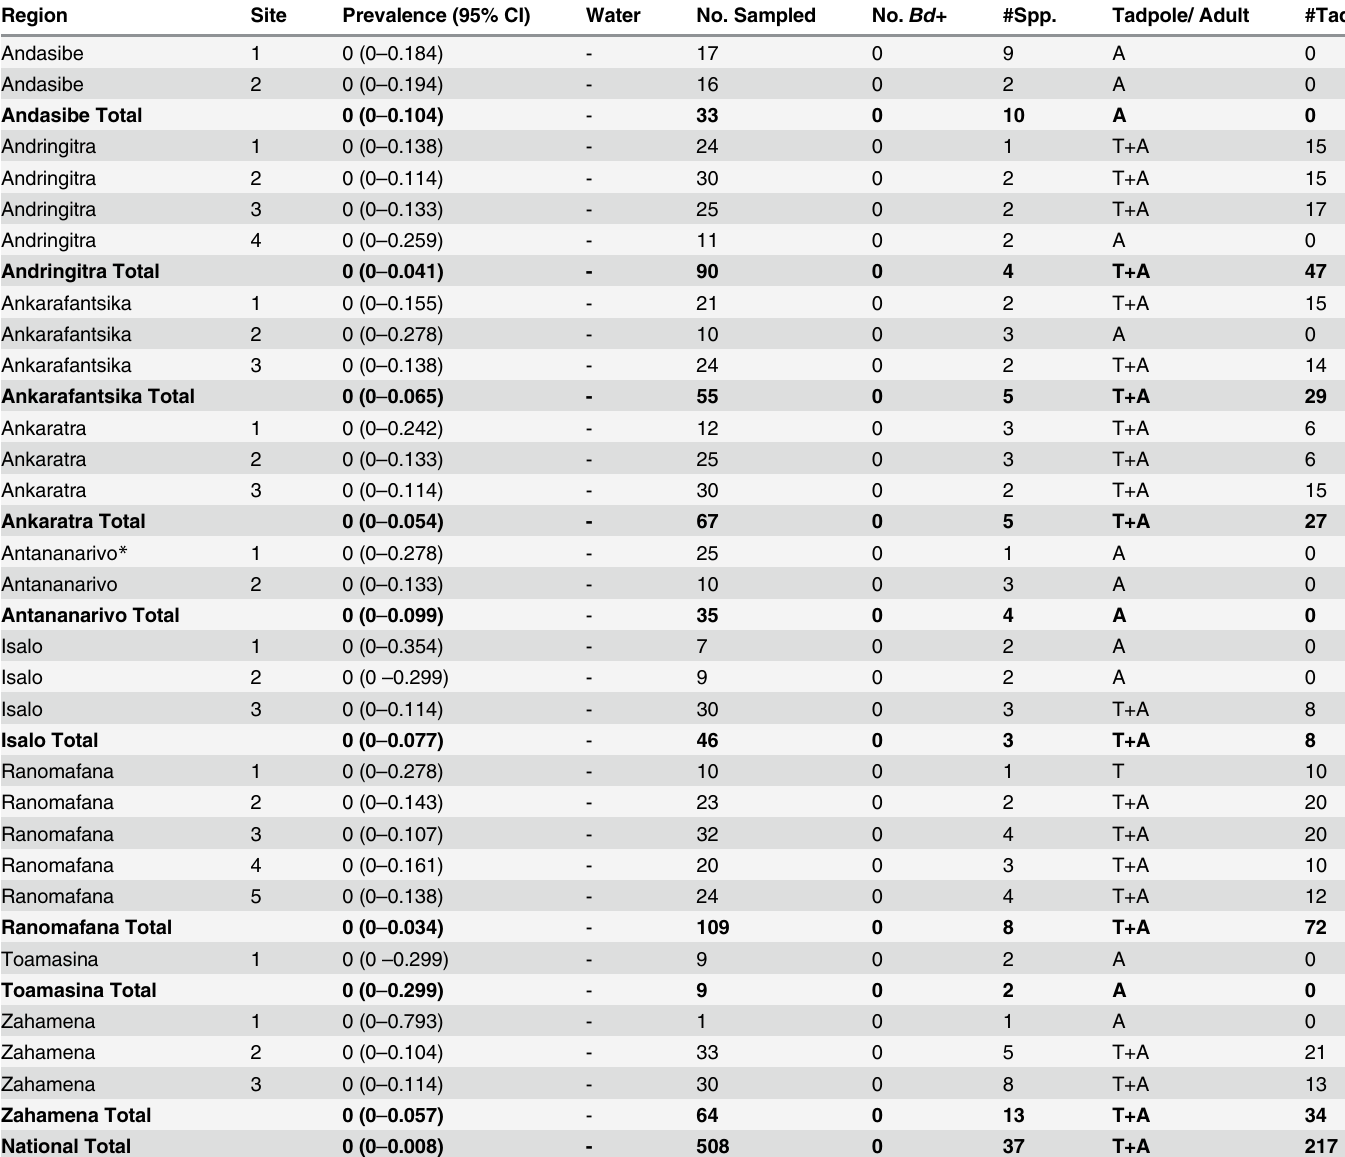
Table 2. Detection of Batrachochytrium dendrobatidis ( Bd ) in Madagascar by quantitative PCR (qPCR) and apparent prevalence including 95% confidence limits (CL) at each location as per swab results, assuming Bd qPCR sensitivity and specificity as per Skerratt et al. (2011) of. 729 and. 942,